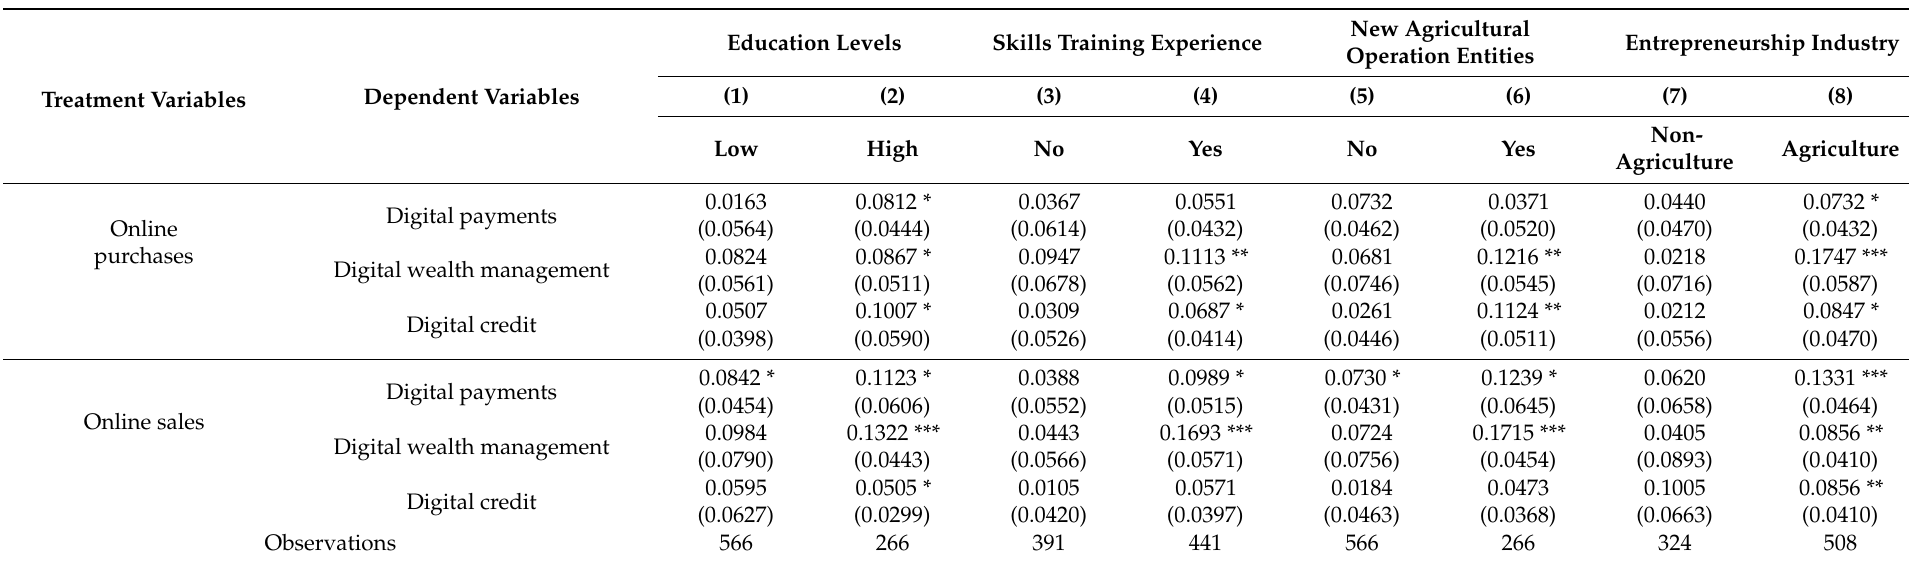
Table 5. Heterogeneity results of the impact of e-commerce adoption on usage of digital